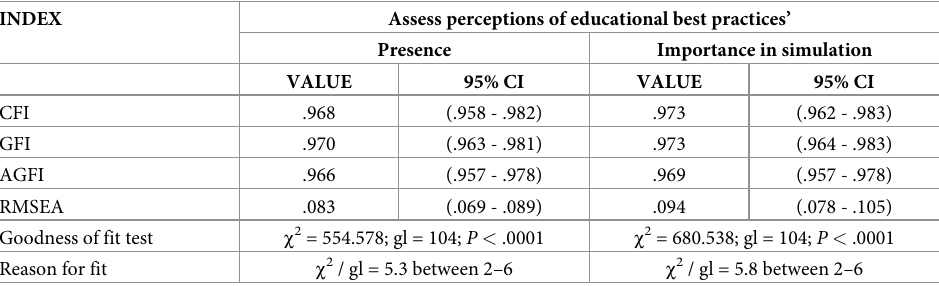
Table 4. Indices of goodness of fit of the exploratory unidimension to the